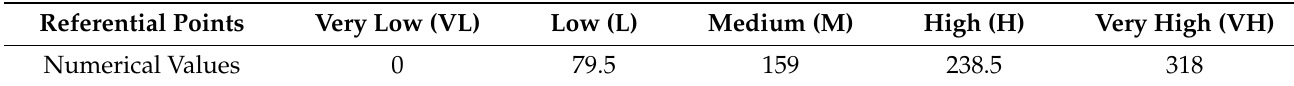
Table 6. The referential points and corresponding numerical values of antecedent high-sensitivity C-reactive protein (hs-CRP).